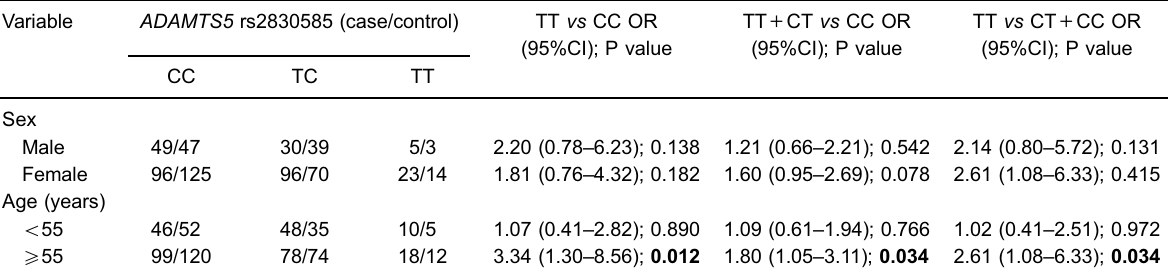
Table 5. Strati fi ed analyses between ADAMTS5 gene polymorphisms and the risk of osteoarthritis.